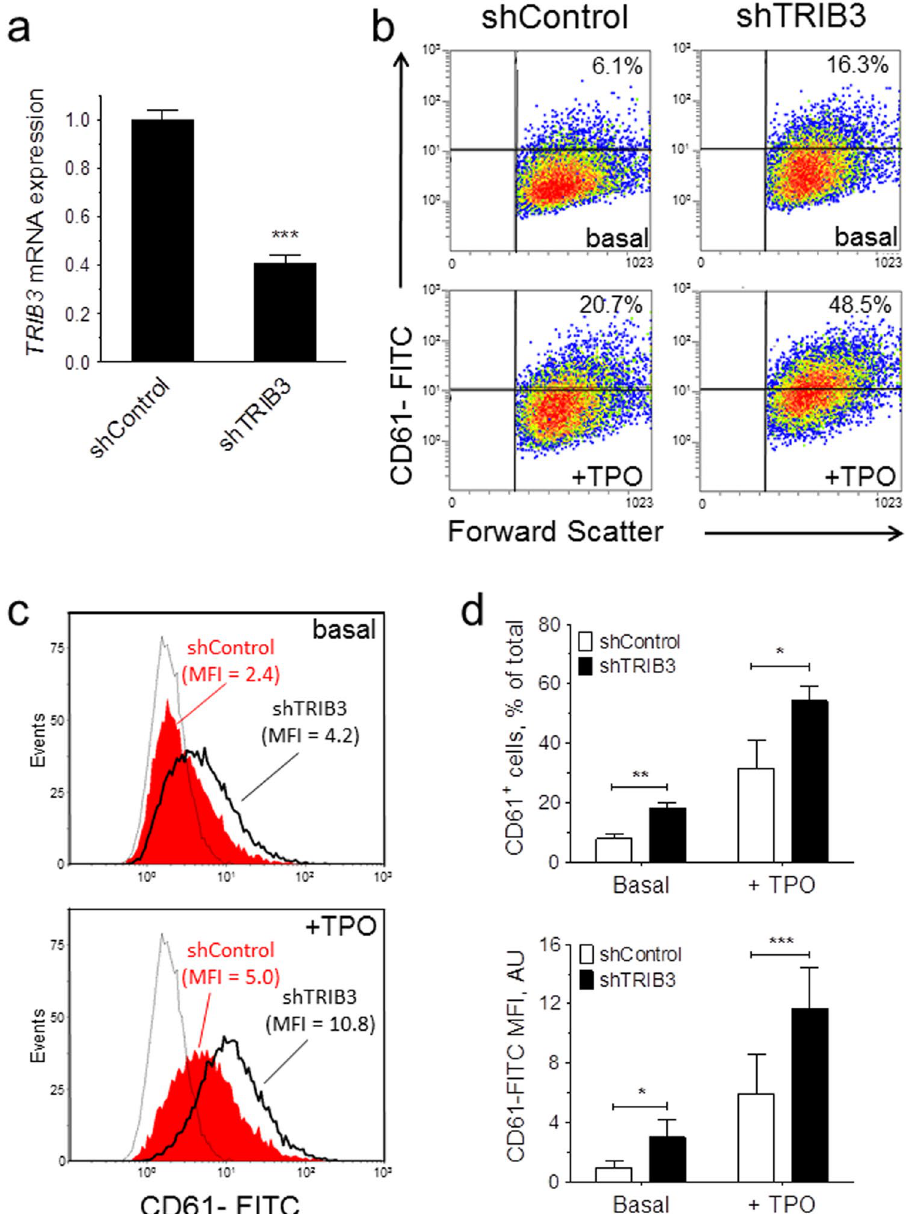
Figure 2. TRIB3 silencing enhances the megakaryocytic differentiation of UT7/mpl cells. shRNA-transduced cells (shControl and shTRIB3.4) were grown for 7 days in the absence (basal) or presence of 100 ng/mL TPO ( + TPO) and then analysed for TRIB3 mRNA and CD61 expression. ( a ) TRIB3 mRNA levels are expressed relative to the basal levels in shControl. Error bars denote SD of pooled Q-PCR data from two independent cultures (n = 6); ( b–d ) Flow cytometric analysis of megakaryocytic differentiation. ( b ) Representative density plots display the percentages of CD61 + cells. ( c ) Representative histogram plots display the median fluorescence intensities (MFI); the faint traces correspond to the fluorescence distribution of samples stained with an isotype- matched control antibody. ( d ) Results of three independent cultures are presented as mean ± SD. * P < 0.05, ** P < 0.01, *** P <